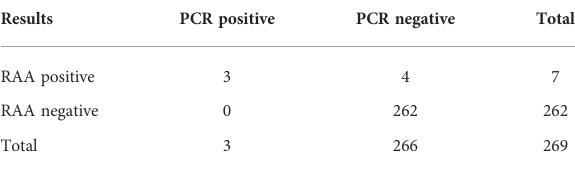
TABLE 2 Testing of clinical samples.